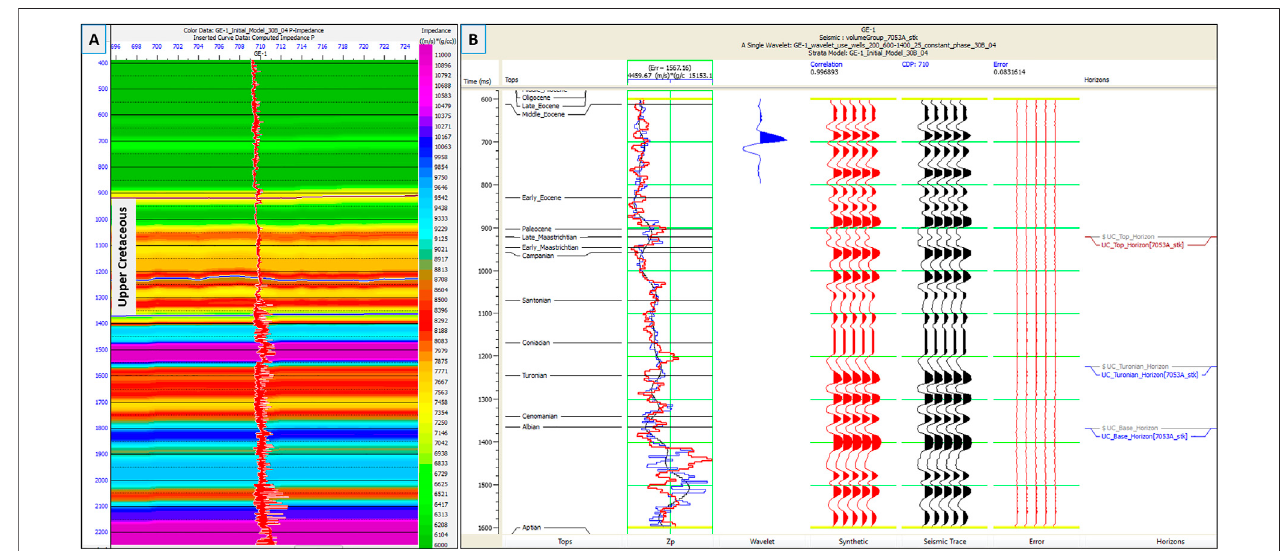
FIGURE 6 | (A) Initial model for the acoustic impedance, and (B) post stack seismic inversion analysis results at the COST GE-1 well.